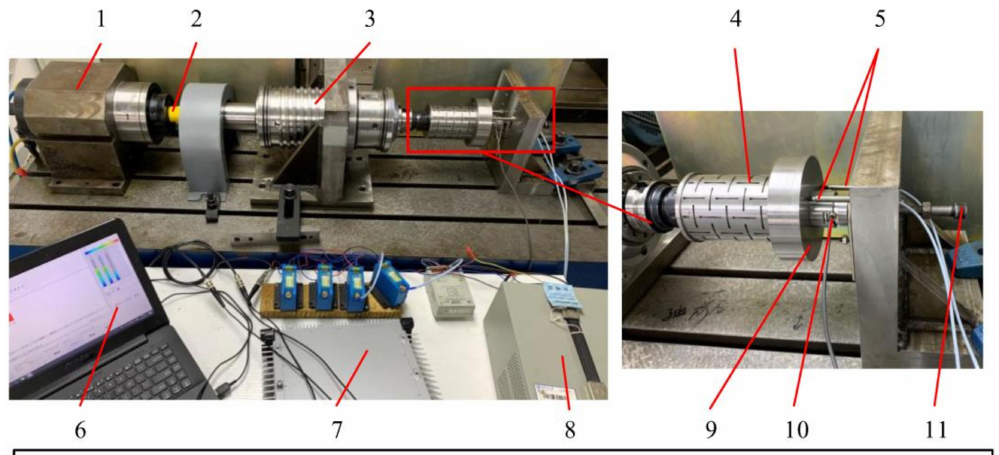
Figure 14. NPR spacer thermo-mechanical coupling test